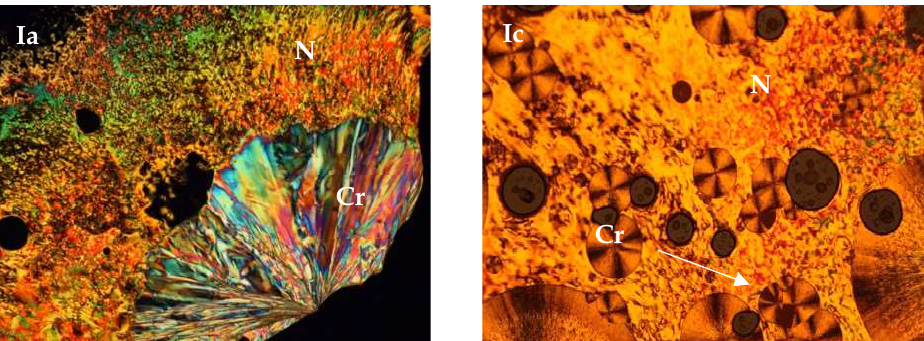
Figure 4. Photos of materials Ia and Ic during the cooling and crystallization processes from the nematic mesophase observed in POM.